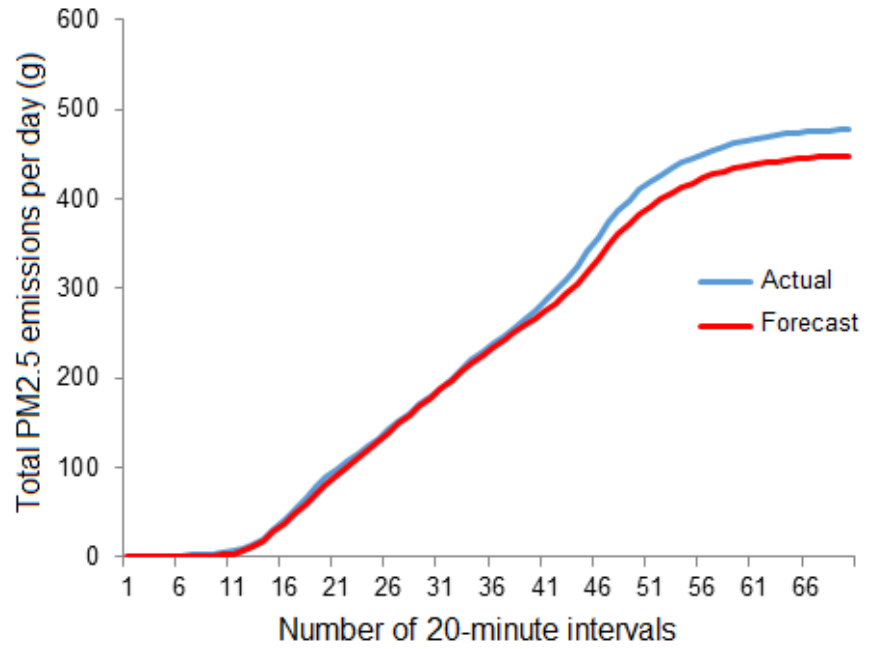
Figure 14. Actual and forecasted cumulative PM2.5 emissions.